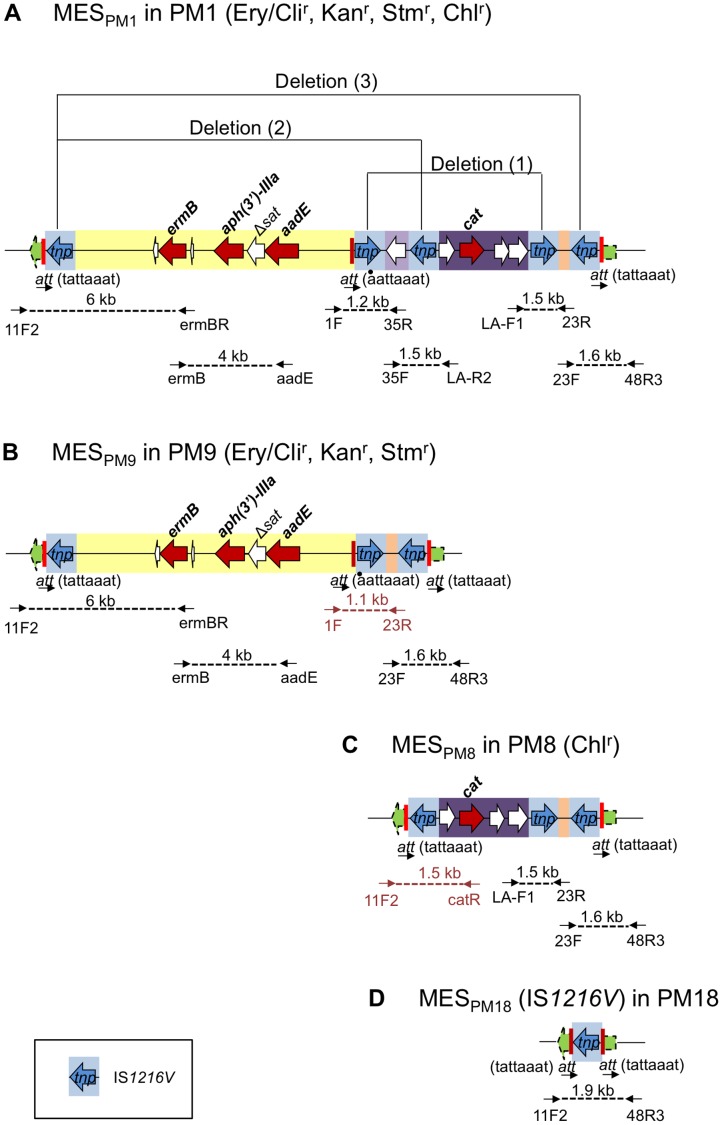
The structure of MESPM1 and its segregants in ST59 CA-MRSA strains.Structures of MESPM1, MESPM9, MESPM8, and MESPM18 (corresponding to IS1216V) are shown in A to D. Drug resistance (r): Ery/Cli, erythromycin/clindamycin; Kan, kanamycin; Stm, streptomycin; Chl, chloramphenicol. The IS1216V region with the transposase gene (tnp) is shaded in blue. The att site is indicated by a vertical red line. Arrows below the MES structures indicate PCR primers, which are listed in Materials and Methods.